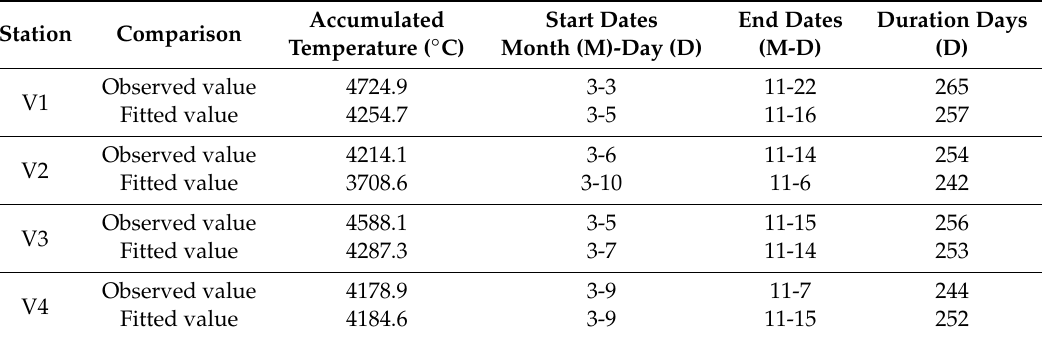
Table 1. Comparison of observed and fitted values of T ≥ 0 ◦ C accumulated temperature.